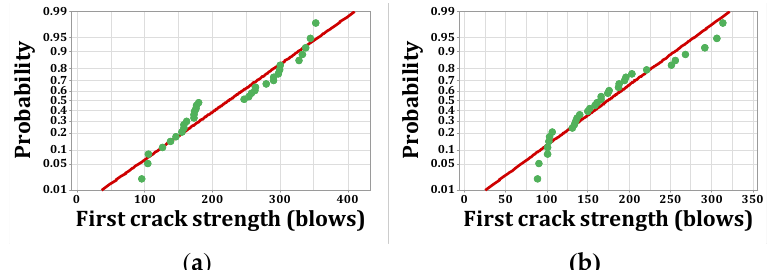
Figure 14. Distribution plots for first crack (humid): ( a ) F5, ( b ) F2F3.